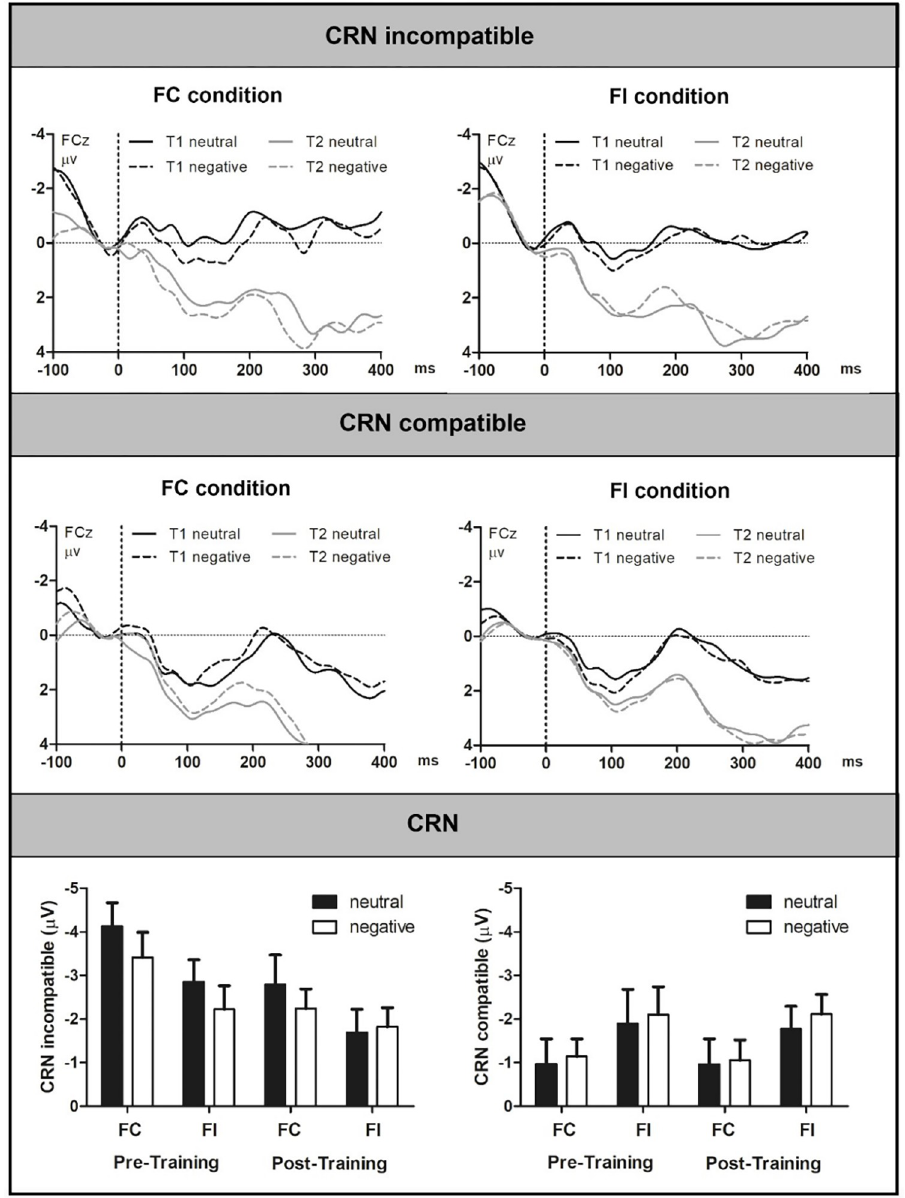
Fig 4. Grand Averages of the CRN in incompatible (upper panel) and compatible trials (middle panel) with neutral and negative pictures in the FC and FI condition at pre- (T1) and post-training (T2) at electrode FCz. The lower panel presents the N2 amplitude in each condition. Bars represent standard errors. FC = frequent compatible, FI = frequent